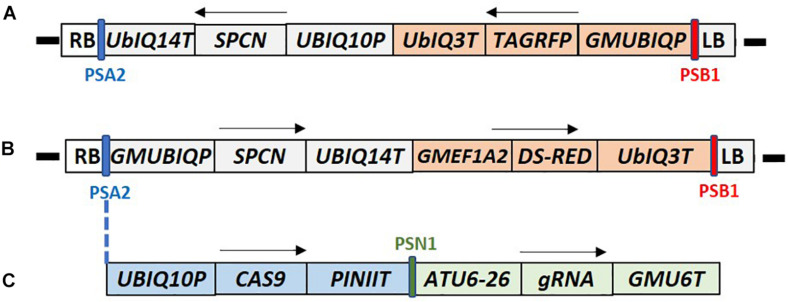
T-DNA maps of the constructs used for canola transformation. (A) Construct RV008033 T-DNA contains Arabidopsis UBIQ10 promoter driven SPCN selectable marker, and TAG-RFP fluorescent marker gene under the control of the soybean UBQ promoter (GMUBIQP); (B) Construct RV028667 T-DNA contains the soybean UBQ promoter driven SPCN selectable marker, and Ds-RED fluorescent marker gene driven by the soybean elongation factor (GMEF1A2) promoter; (C) Construct RV29164 T-DNA contains SPCN selectable marker, and Ds-RED fluorescent marker gene similar to RV028667. In addition it also contains single guide RNA (sgRNA) and CAS9 expression cassette inserted between PSA2 and GMUBIQP. T-DNA components shown in these maps are described in Supplementary Table 2. PSA2, PSN1, SPCN, and PSB2 regions of the maps were used for Q-PCR detection as described in Supplementary Table 3. RB and LB indicate T-DNA right and left border, respectively. Arrows indicate direction of the transcription. Sizes are not to the scale.